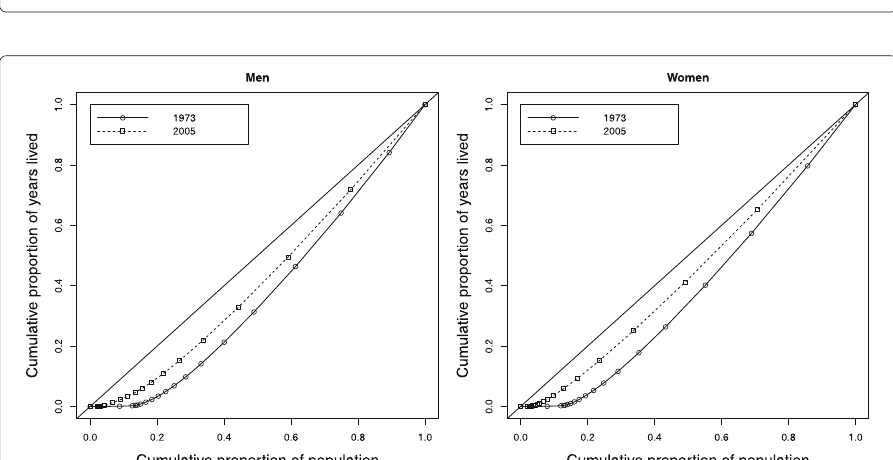
Fig. 11 Evolution of Lorenz curve, Colombia, selected years 1973 (solid line) and 2005 (dotted line), men and women